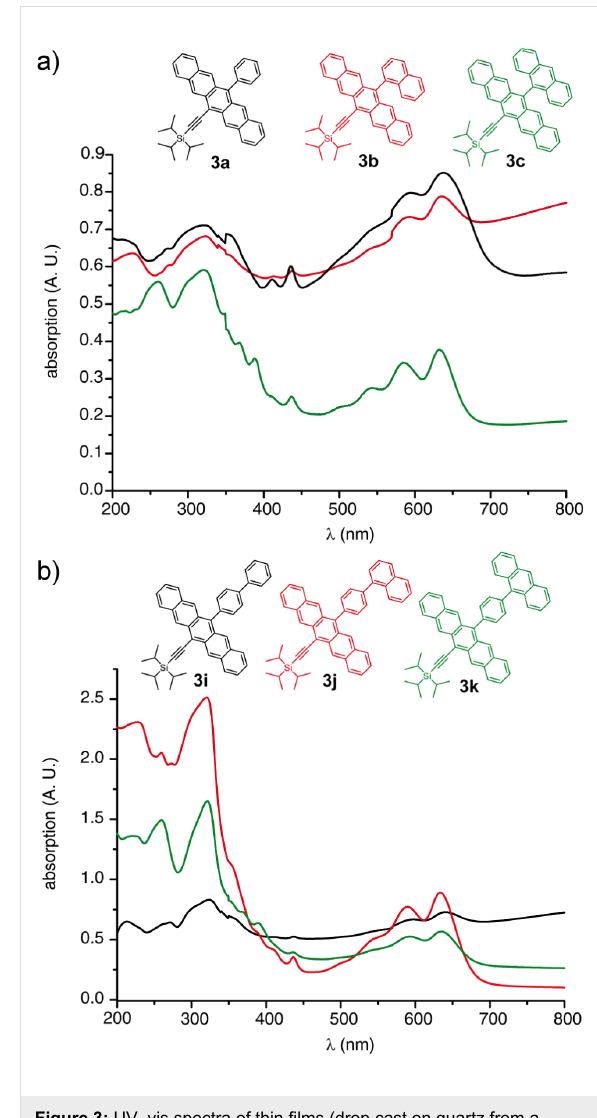
Figure 3: UV–vis spectra of thin films (drop cast on quartz from a CH 2 Cl 2 solution) for pentacenes a) 3a – c and b) 3i – k